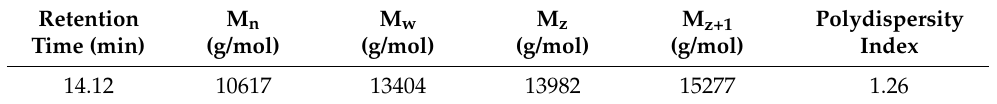
Table 3. Molecular weight distribution of the polysulfonate dispersants.